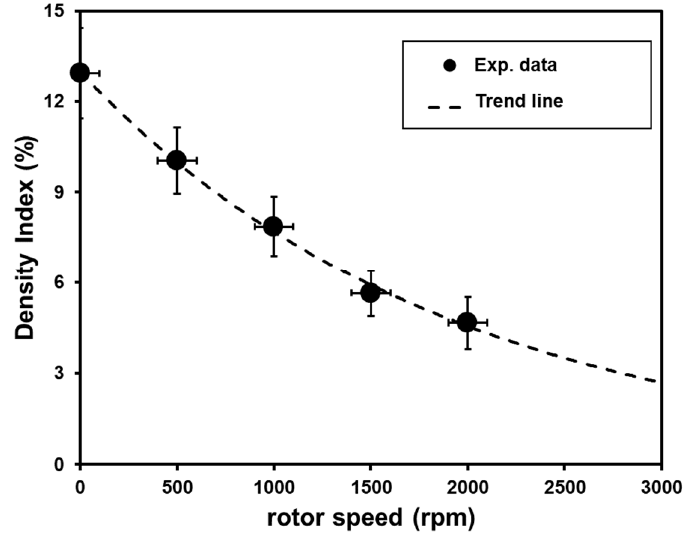
Figure 14. Density Index versus rotor speed during continuous in-line HSMC degassing of an aluminum A380 alloy melt at 700 ◦ C, poured at a melt flow rate of 120 kg/h. Reprinted with permission from [28]. Copyright 2022 Elsevier.